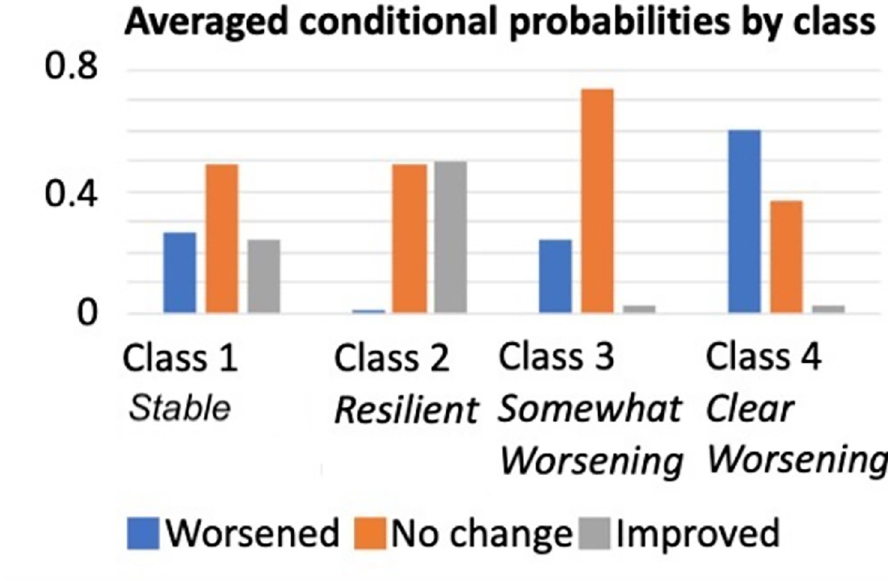
Fig 1. Averaged conditional probabilities by